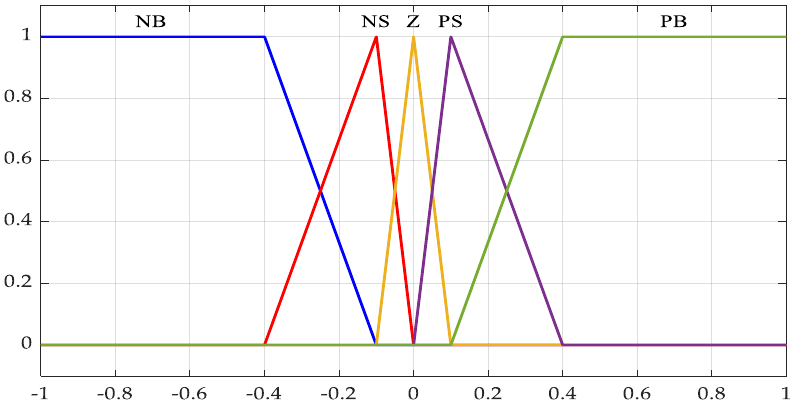
Figure 3. Membership functions of the two inputs and output. Table 2. Fuzzy rule base of the proposed controller.